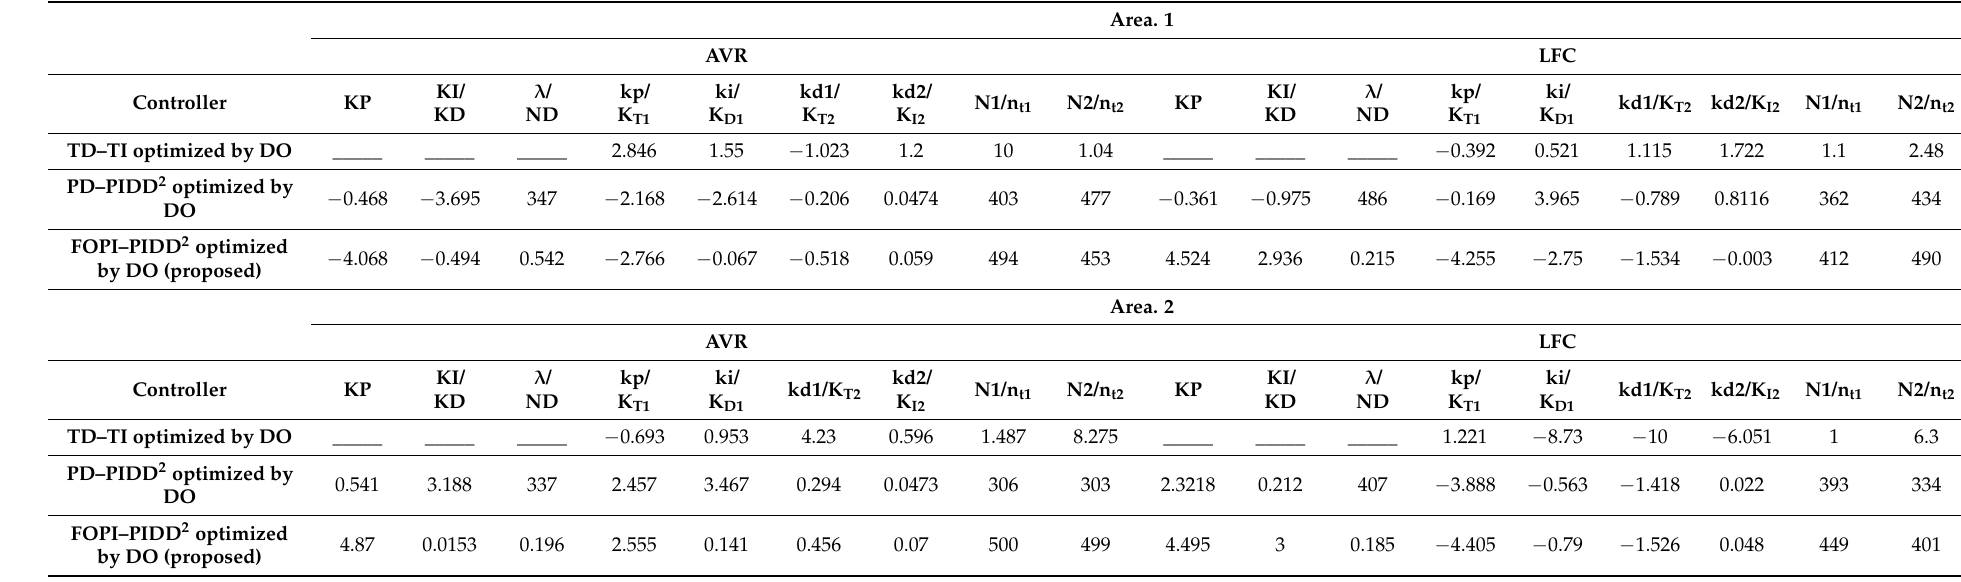
Table 9. Optimal parameters of the three controllers for scenario 7.